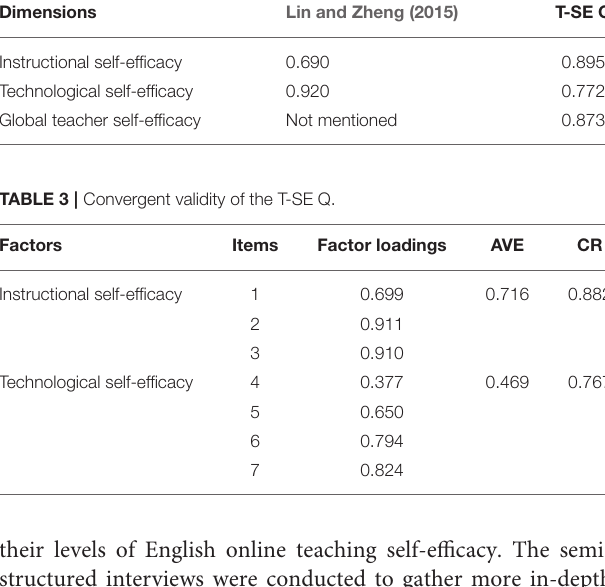
TABLE 2 | Internal consistency of the questionnaire (Lin and Zheng, 2015) and T-SE Q. Dimensions